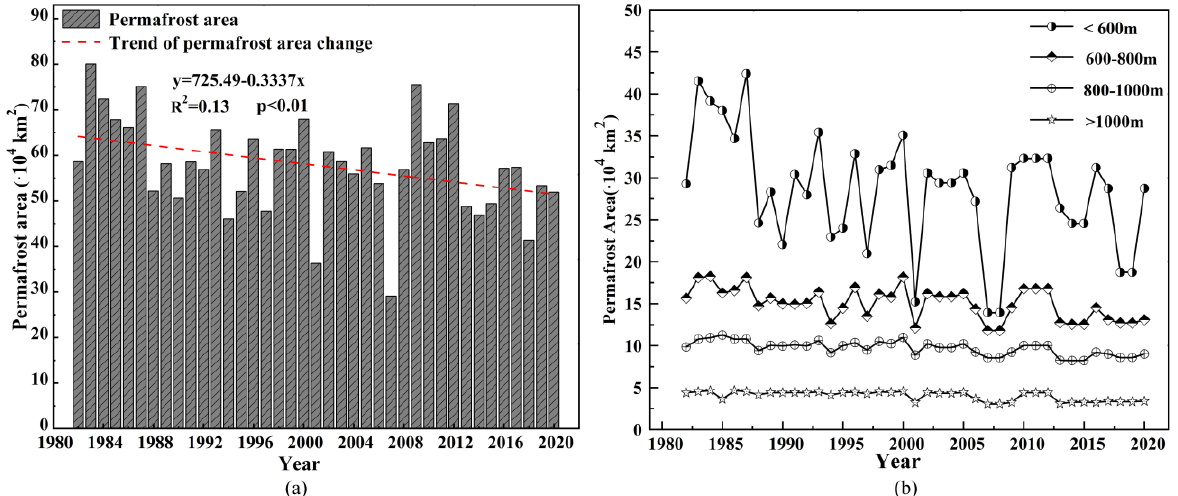
Figure 4. ( a ) The variation of the permafrost area (significant at the p < 0.01 level, with a 95% confidence level) and ( b ) the variation characteristics at different altitudes.